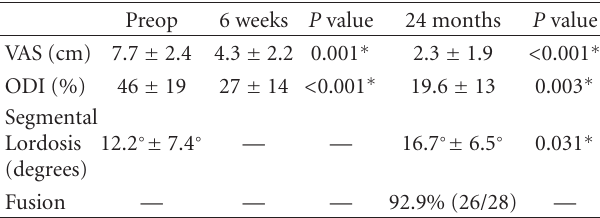
Table 1: Clinical and radiological